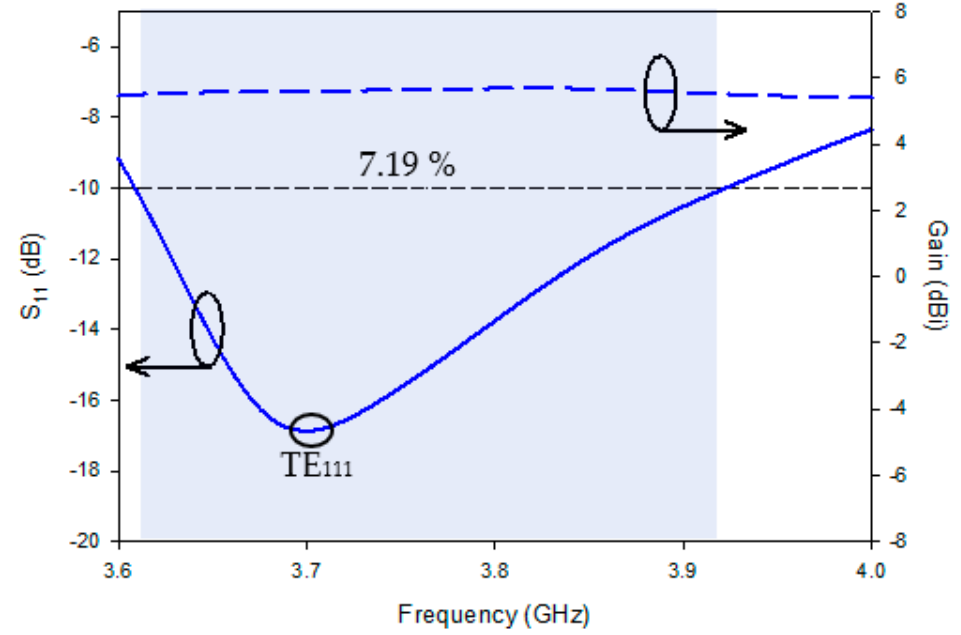
Figure 4. Simulated S-parameter and Gain of the single unit of linearly polarized RDRA.